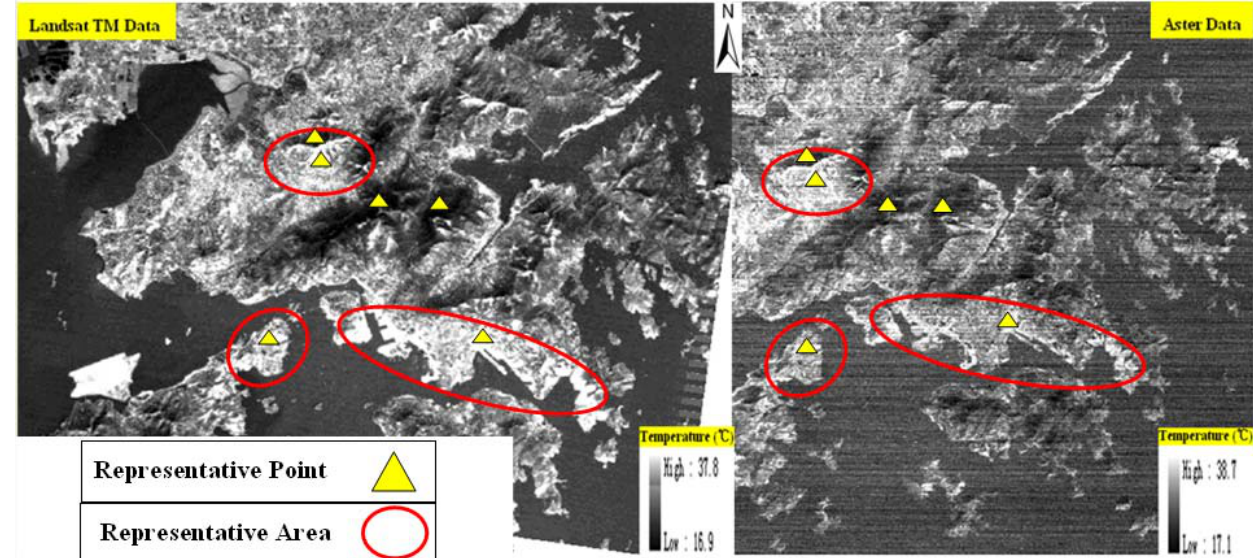
Figure 5. The representative points and areas of two LST retrieving results.